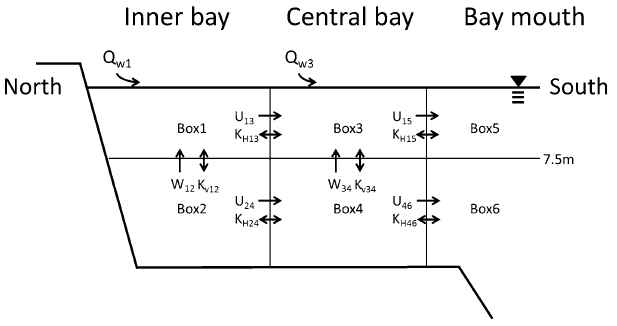
Figure 2. Cross-section of box model in Tokyo Bay. Q indicates amount of supply from rivers and sewage treatment effluent, U and W indicate horizonal and vertical flow velocity, respectively, and K is diffusion coefficient (see Supplementary Information for more details on calculation of each